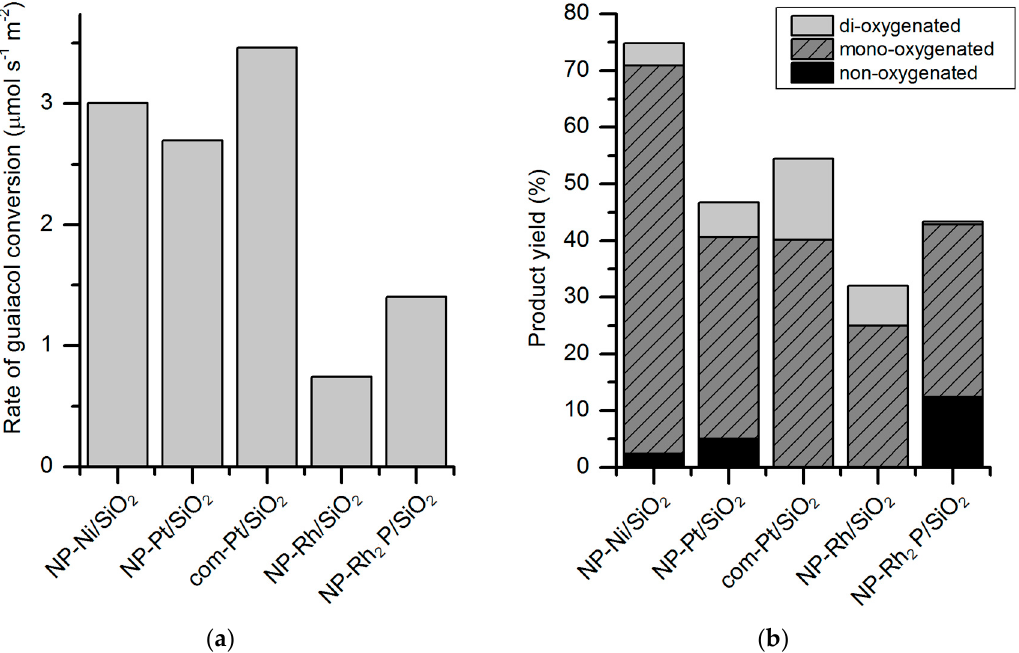
Figure 9. ( a ) Conversion rate normalized per square meter (m 2 ) of active phase surface area observed during the hydrodeoxygenation of guaiacol; ( b ) Product yield of non-, mono- and di-oxygenated species from guaiacol HDO. “NP” is for nanoparticles, “com” for commercial. Reaction conditions: 350 °C, 0.5 MPa, 12 H 2 :1 guaiacol, WHSV 5 h − 1 . Graphics are redrawn according to Reference [47].